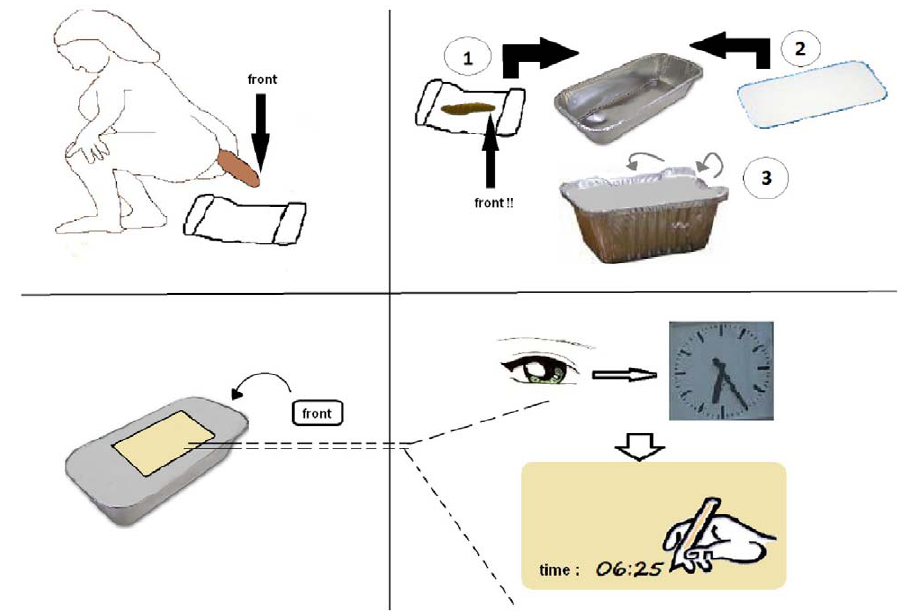
Figure 1. Instruction form on how to collect whole-stool samples for the study.